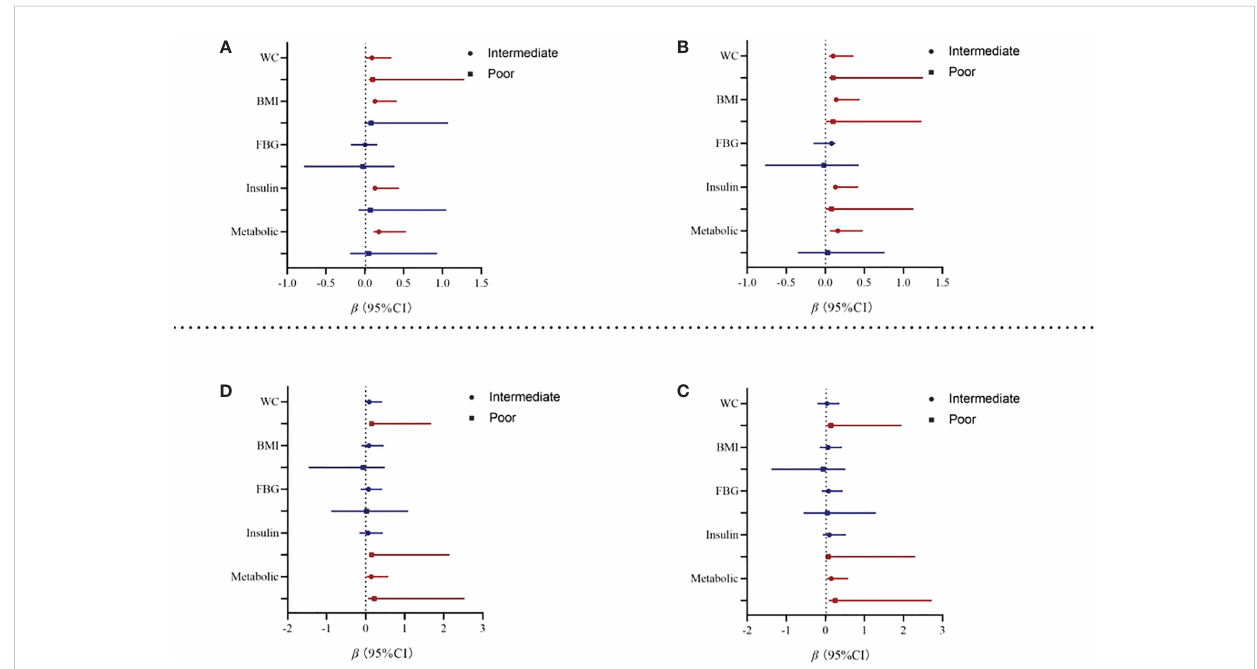
FIGURE 2 Association from multivariate linear regression model between sleep and metabolic parameters. Note: WC, waist circumference; BMI, body mass index; FBG, fasting blood sugar. Model 2 adjusted for baseline gender, cigarette consumption, alcohol consumption, physical activity, mobile phone addiction, depression, and anxiety. (A) Baseline Model 1. (B) Baseline Model 2. (C) Two-year follow-up Model 1. (D) Two-year follow-up Model 2.